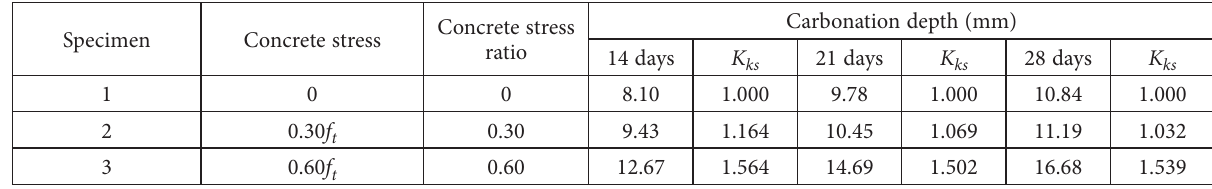
Table 6. Carbonation depths of specimens under different concrete stress conditions (data from Zhou, 2011)